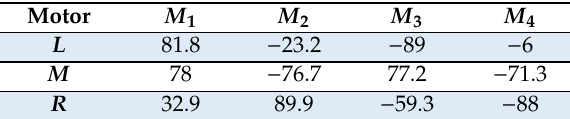
Table 2. Rotation angle of each individual